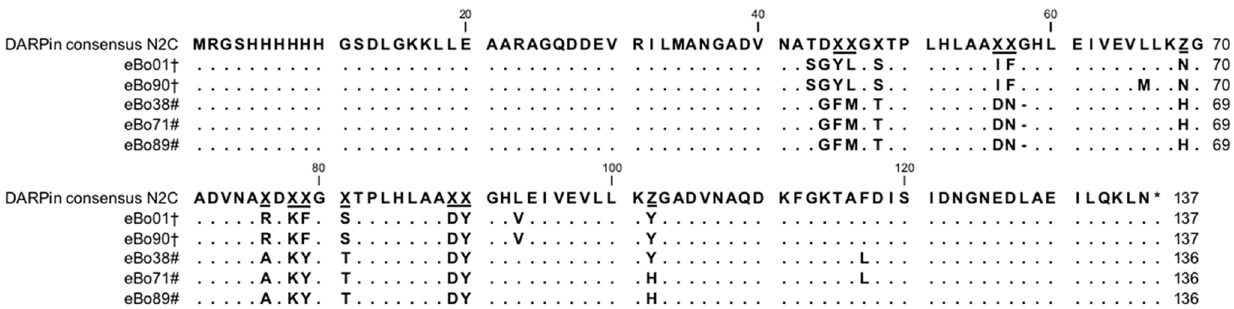
Figure 2. Sequence analysis of Bo2C11–specific DARPin clones. Plasmid DNA of positive clones was sequenced and aligned with the N2C DARPin consensus sequence. In the consensus module position X allows any amino acid except Cys, Pro or Gly and Z can be either His, Asp or Tyr. Based on the sequence homologies, DARPins were grouped to group 1( { ) or group 2 ( # ), respectively. Identical residues are displayed as dots.